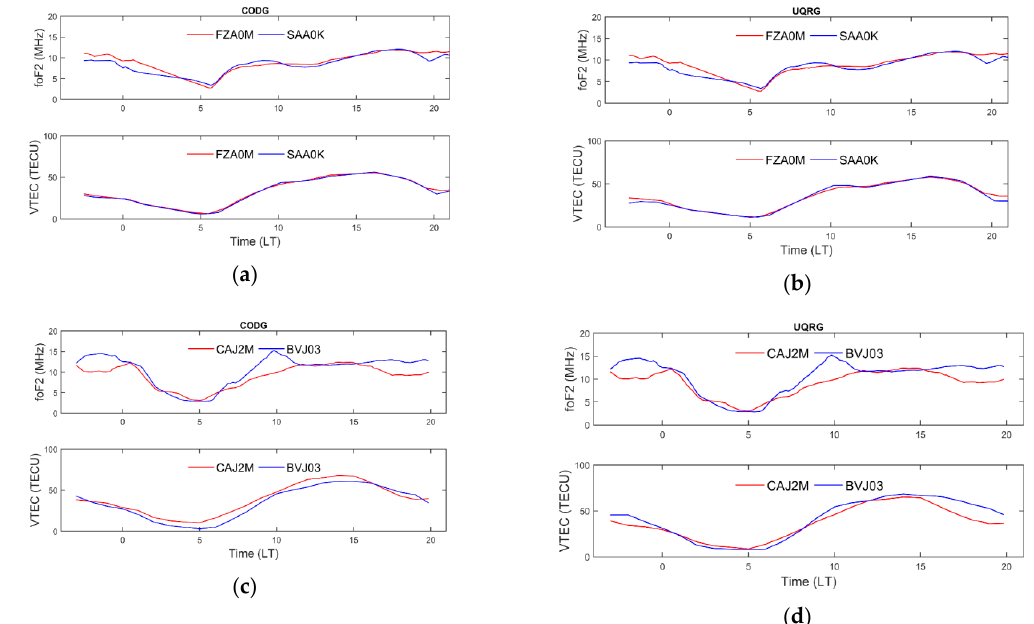
Figure 2. Comparison of the fo F 2 measured with ionosondes and VTEC values estimated for the respective ionosondes using CODG ( a , c ) and UQRG ( b , d ).